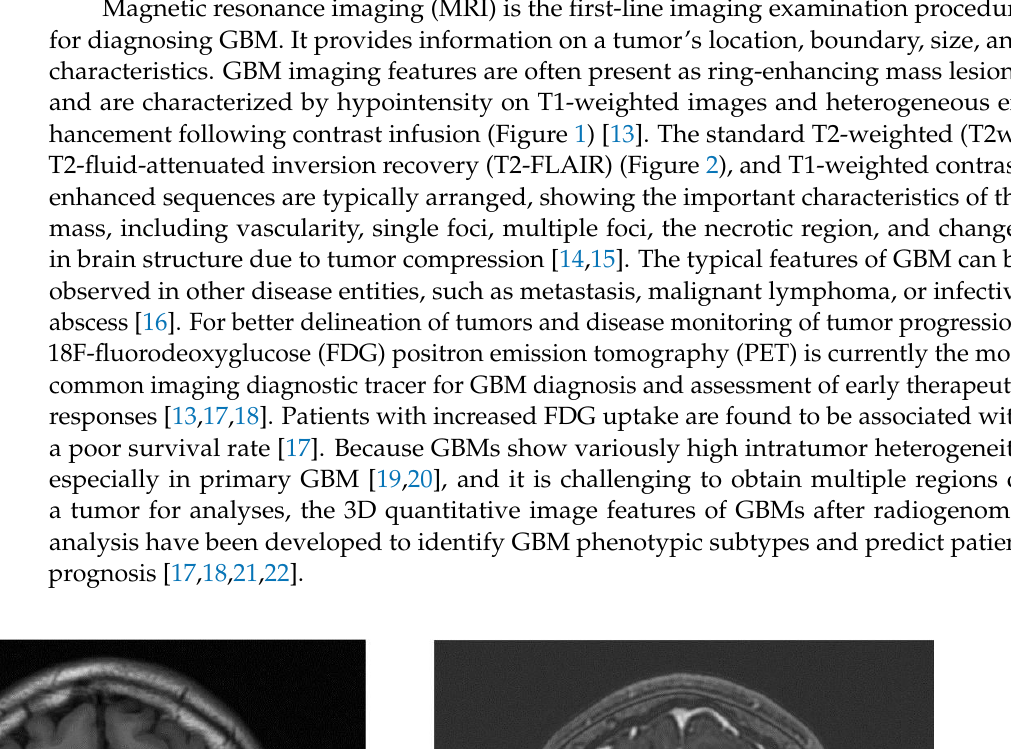
Figure 2. MRI T2-weighted fluid attenuation inversion recovery (FLAIR) axial image demonstrates a hyperintense mass lesion (arrow). 1.2. Current Treatment GBM is one of the most lethal cancers with a very poor 5-year survival rate despite advanced therapeutic options in chemotherapy, immunotherapy, and radiation [27]. The current standard policy of GBM includes maximal surgical resection if possible, followed by a combination of chemotherapy and/or radiotherapy. Maximal surgical resection is the first step after confirmation through medical imaging. Radiographic total resection is the most prognostic and a higher extent of tumor resection (>90%) is significantly asso- ciated with better one-year survival [28,29]. In the current temozolomide (TMZ) era, maximal resection also confers a significant overall survival benefit in patients with re- current and resectable GBM [29]. Radiotherapy has been used in patients with residual tumors for more than several decades [30]. Radiation therapy causes tumor cell apoptosis through DNA double-strand breaks [31]. However, approximately 50% of GBMs express amplification of the epider- mal growth factor receptor (EGFR) gene, whose truncated variant III, EGFRvIII, which is